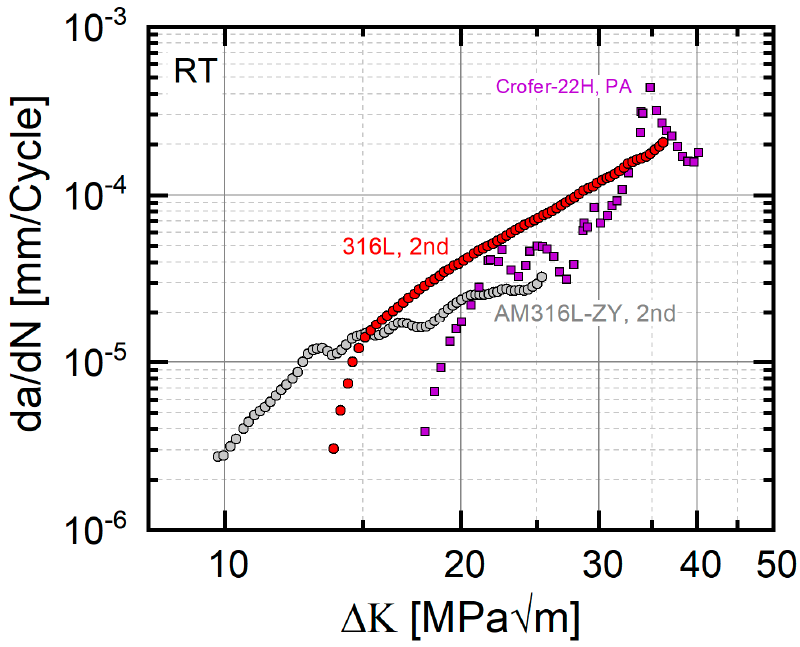
Figure 19. Cyclic crack propagation curves of additively manufactured 316L (AM316L-ZY), conventionally manufactured 316L, and Crofer22 H (after precipitation annealing: 0.5 to 10 h from 600–650 °C) at ambient temperature.